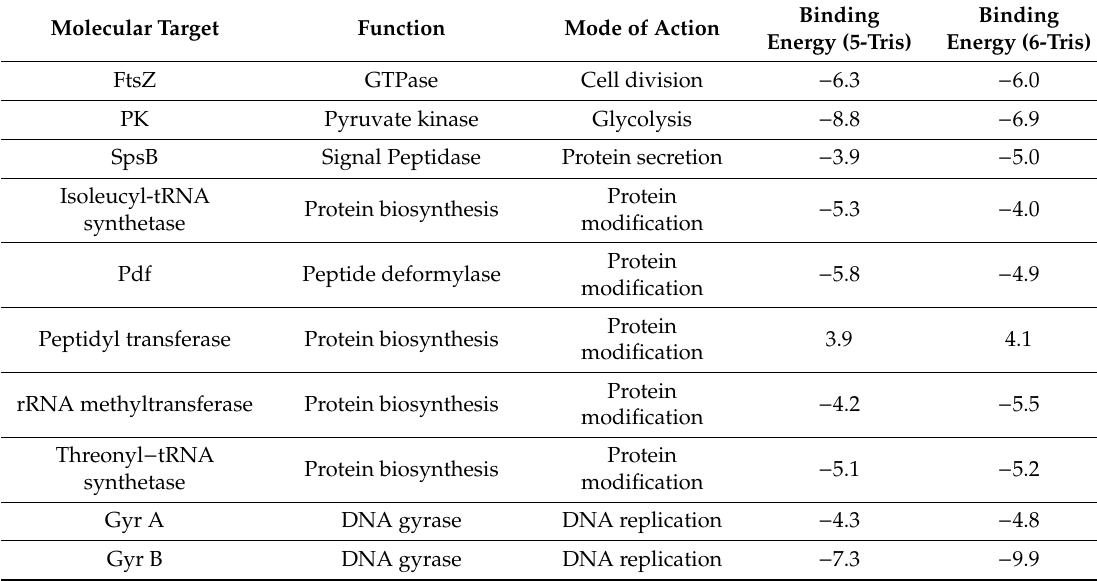
Binding energies (kcal / mol) of 5-Tris and 6-Tris against a number of possible staphylococcal